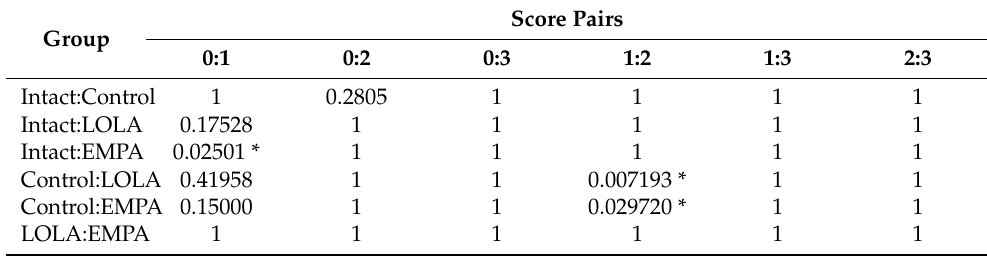
Table A6. Adjusted p -values for central vein fibrosis score frequency